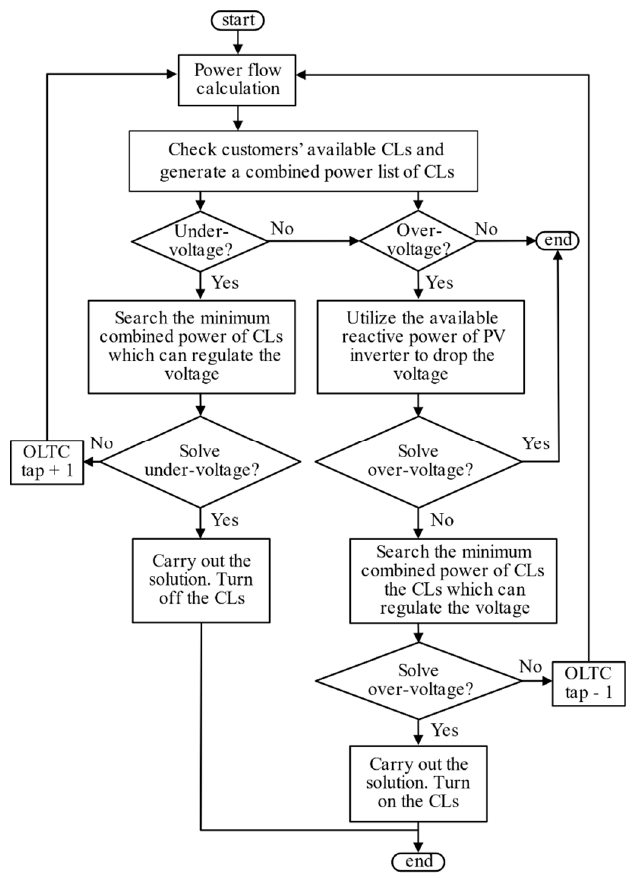
Figure 4. Flowchart of real-time voltage regulation via controllable load (CL).